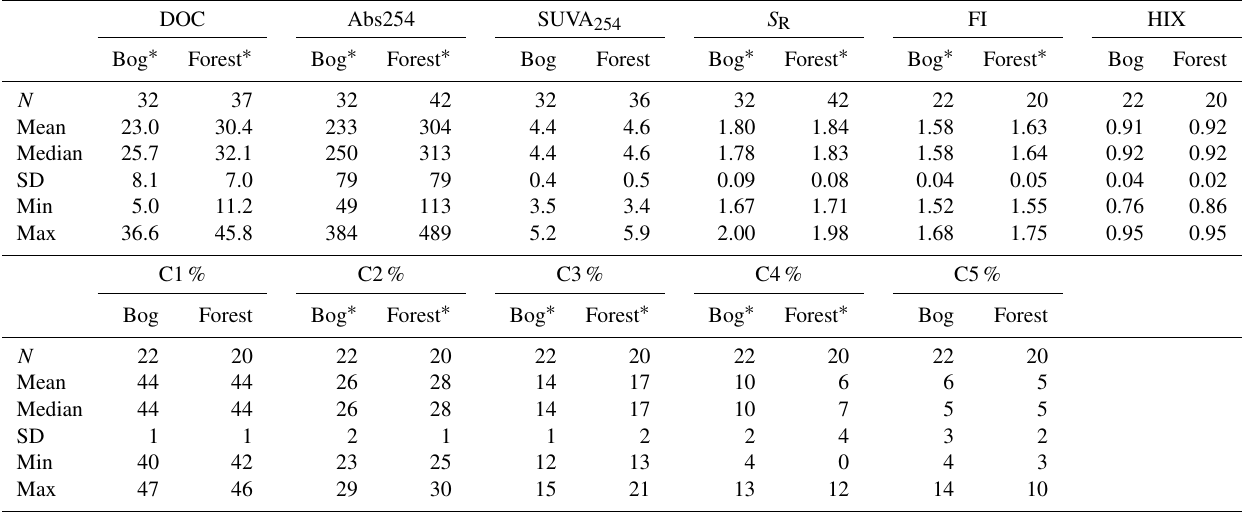
Table 1. General descriptive statistics (mean, median, standard deviation (SD), minimum and maximum values) for DOC concentrations, and DOM quality parameters (abs 254nm , SUVA, S R , FI, HIX, C1%, C2%, C3%, C4% and C5%) over the whole sampling period. High- resolution rain event data are excluded to project seasonal